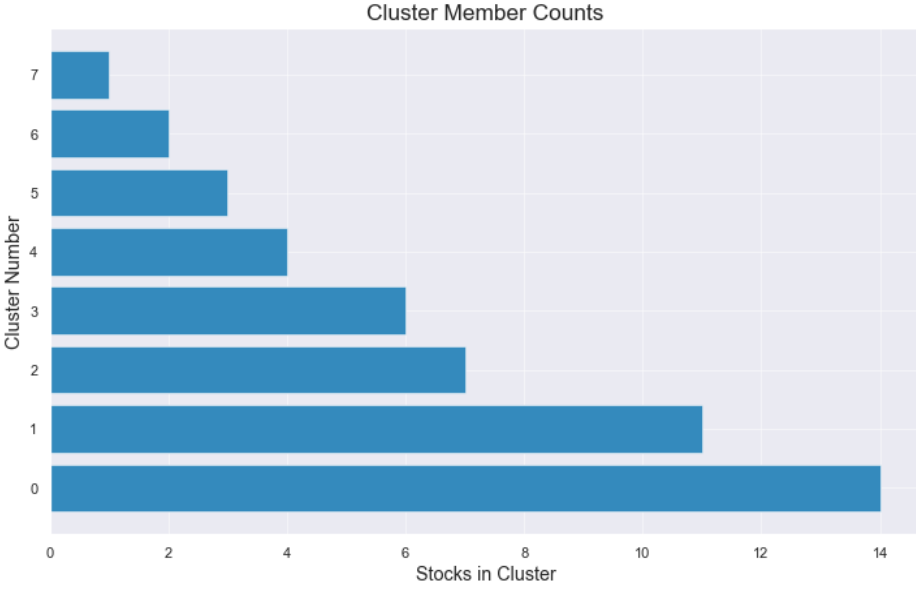
Figure 11. Number of shares in each cluster by affinity propagation Clustering method